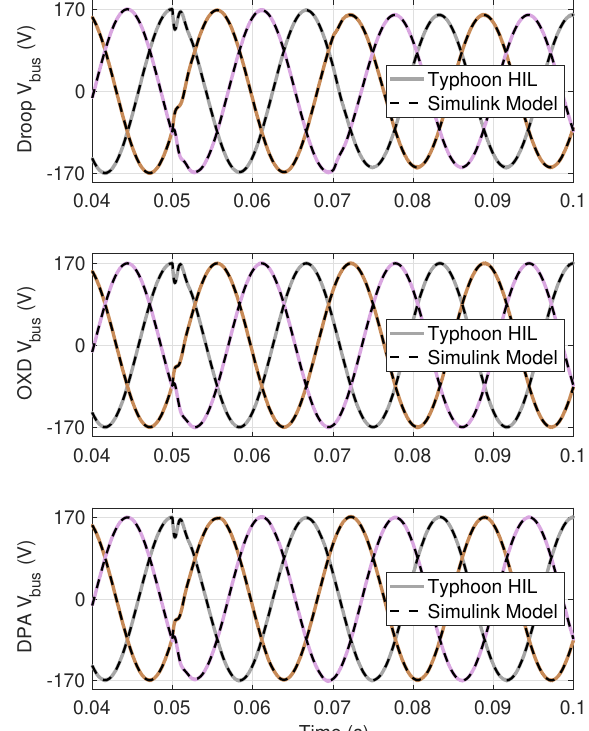
Figure 4. Model Verification: Typhoon HIL 602 three-phase bus voltage response to a bus load step change at t = 0.05 s and a source step change at t = 0.07 s, overlaid with c-coded S-Functions simulation